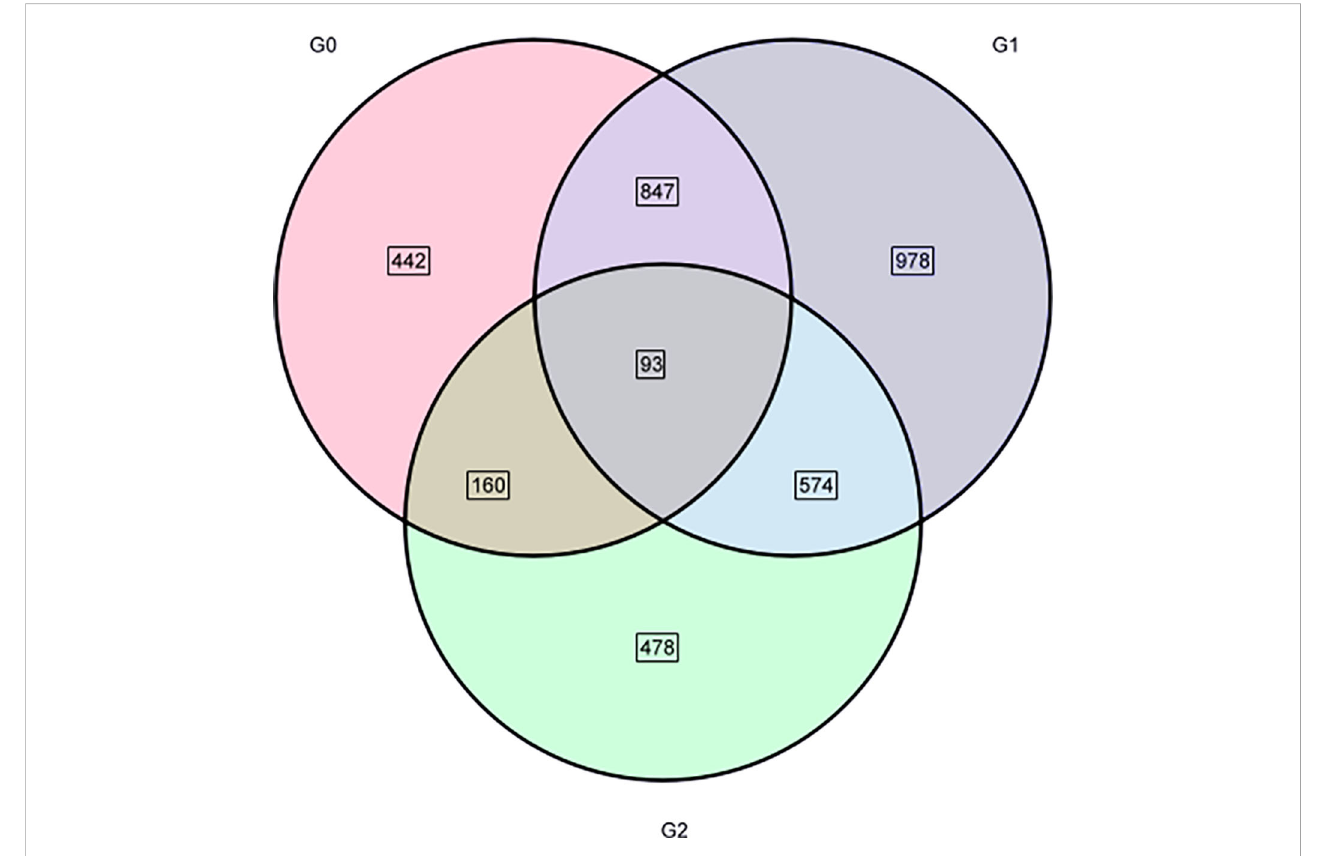
FIGURE 8 Venn diagram of the three groups of